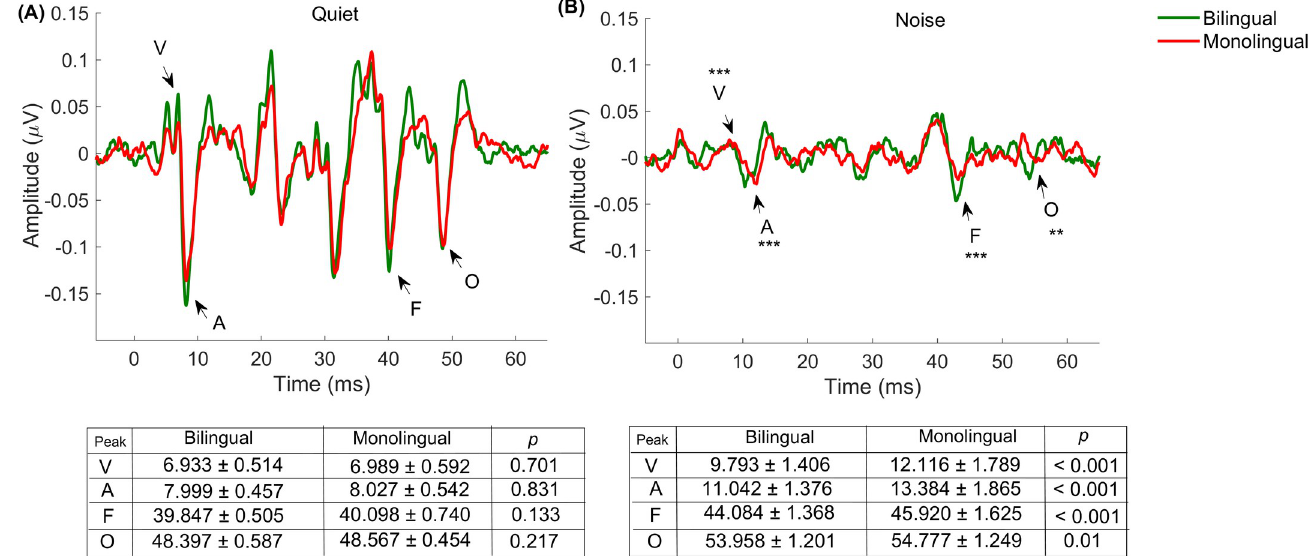
Fig 1. Grand average subcortical responses to speech stimuli obtained from bilinguals (green) and monolinguals (red) recorded in quiet (A) and noise (B) . �� p � 0.01; ��� p � 0.001. Significant group differences between peak latencies (as revealed in t tests for independent samples) were found in noise. The tables below represent means ± SD (ms) for peak latencies in quiet (right) and noise (left), and the p value for the group differences.